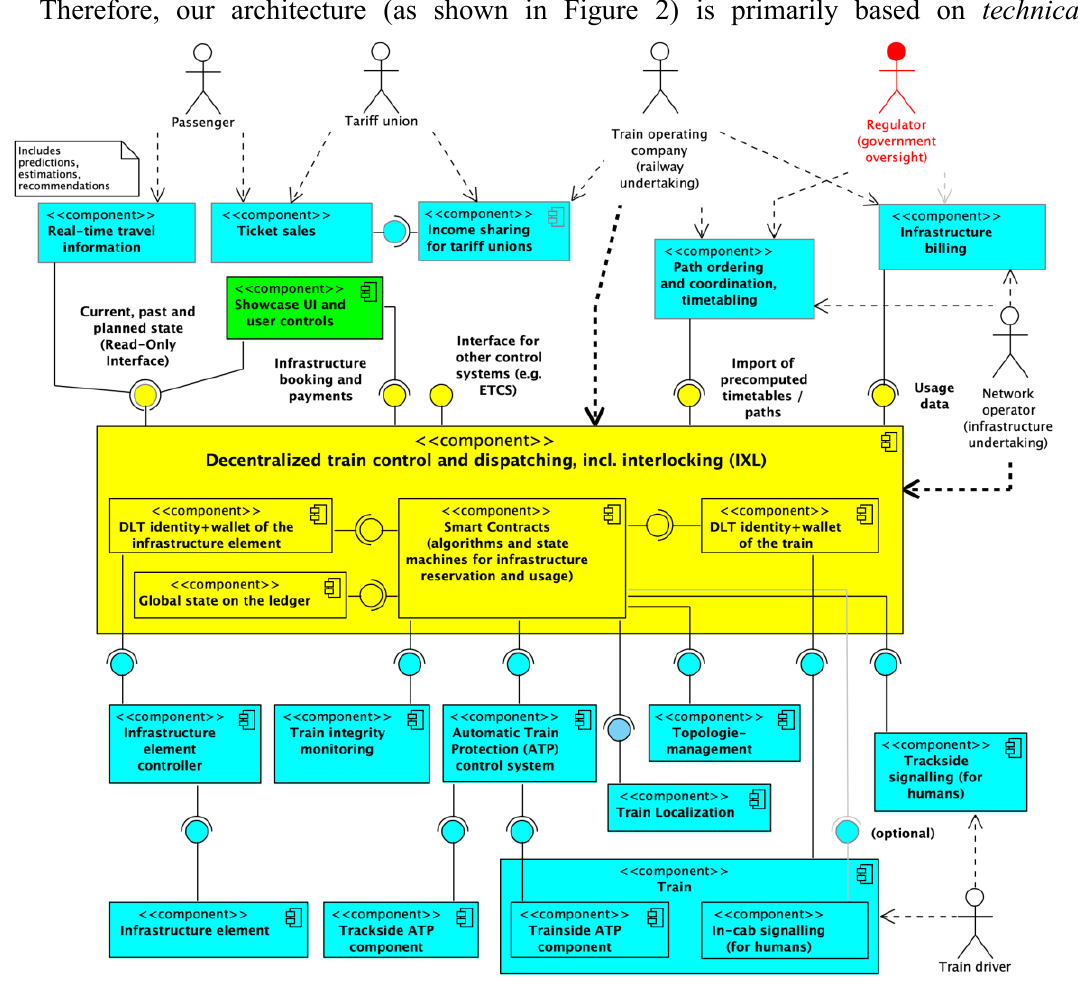
Fig. 2. Case study architecture (partially implemented by the